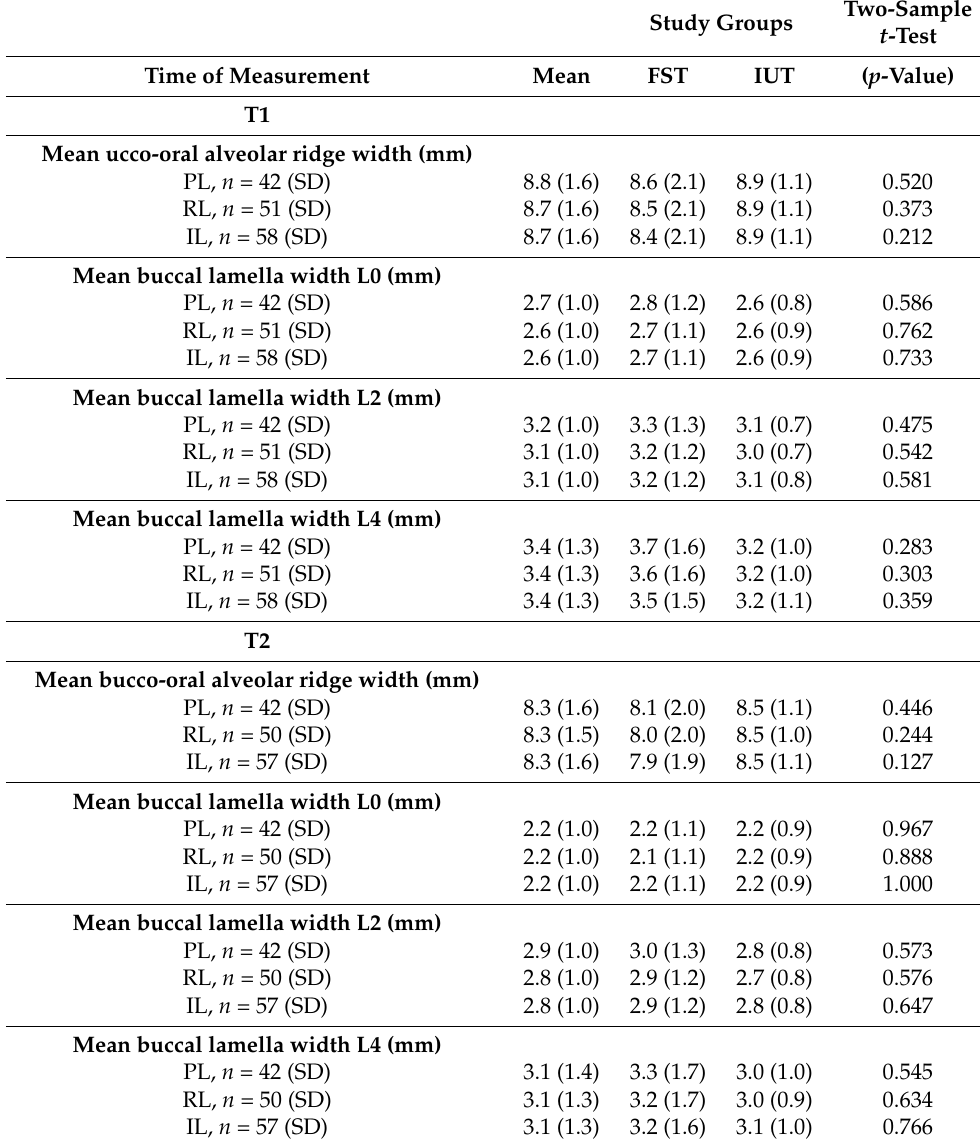
Table 3. Mean alveolar ridge bone measurements directly after grafting (T1) and at the time of follow-up (T2).